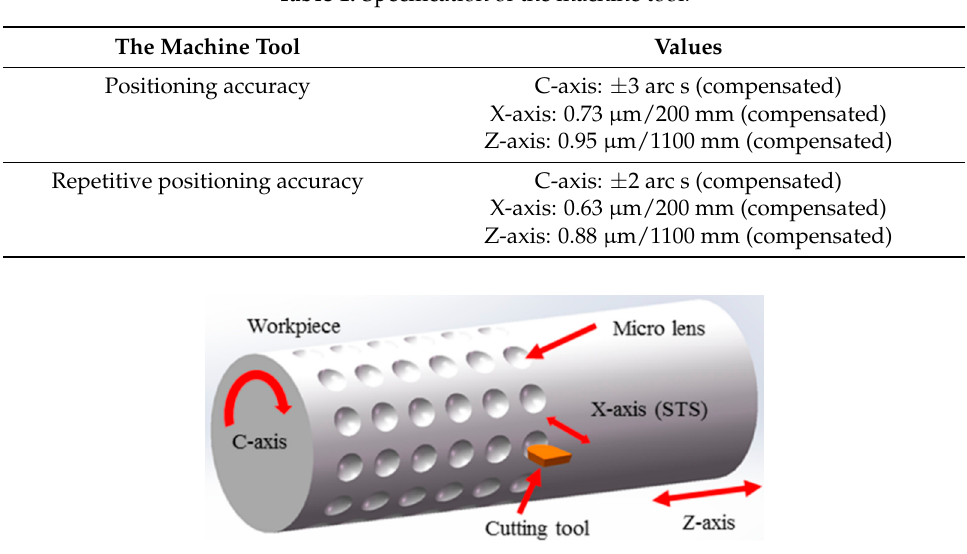
Figure 6. Schematic of slow tool servo (STS) diamond turning of micro lens arrays (MLAs).